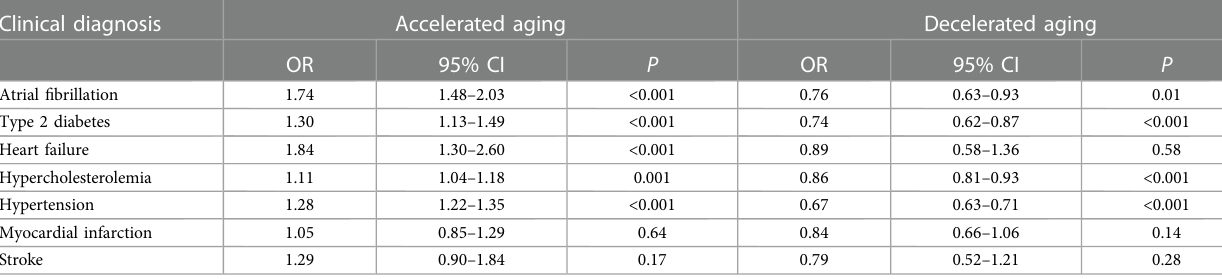
TABLE 2 Association of accelerated aging and decelerated aging with prevalent cardiovascular disease and risk factors. Clinical diagnosis